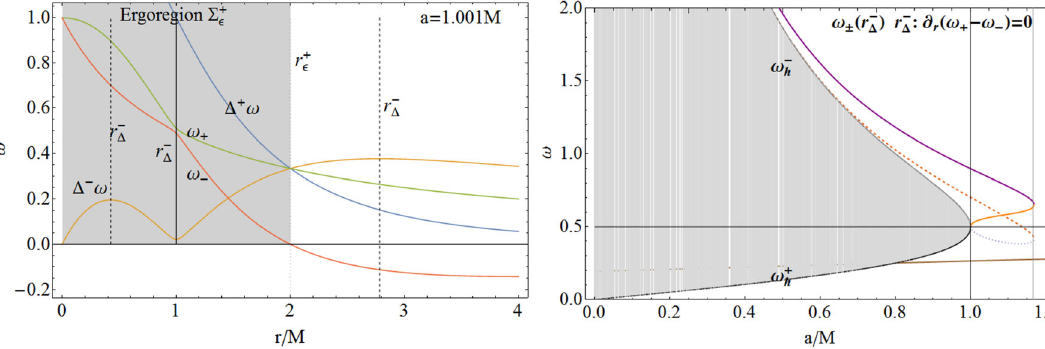
radii r − (cid:2) and critical points of the curves ω ± are also shown. Note the role of the static limit r + (cid:9) and the r − (cid:2) in the bottleneck definition. Right panel: curves ω ± on r − (cid:2) , i.e., solutions of ∂ r (cid:2) − ω =